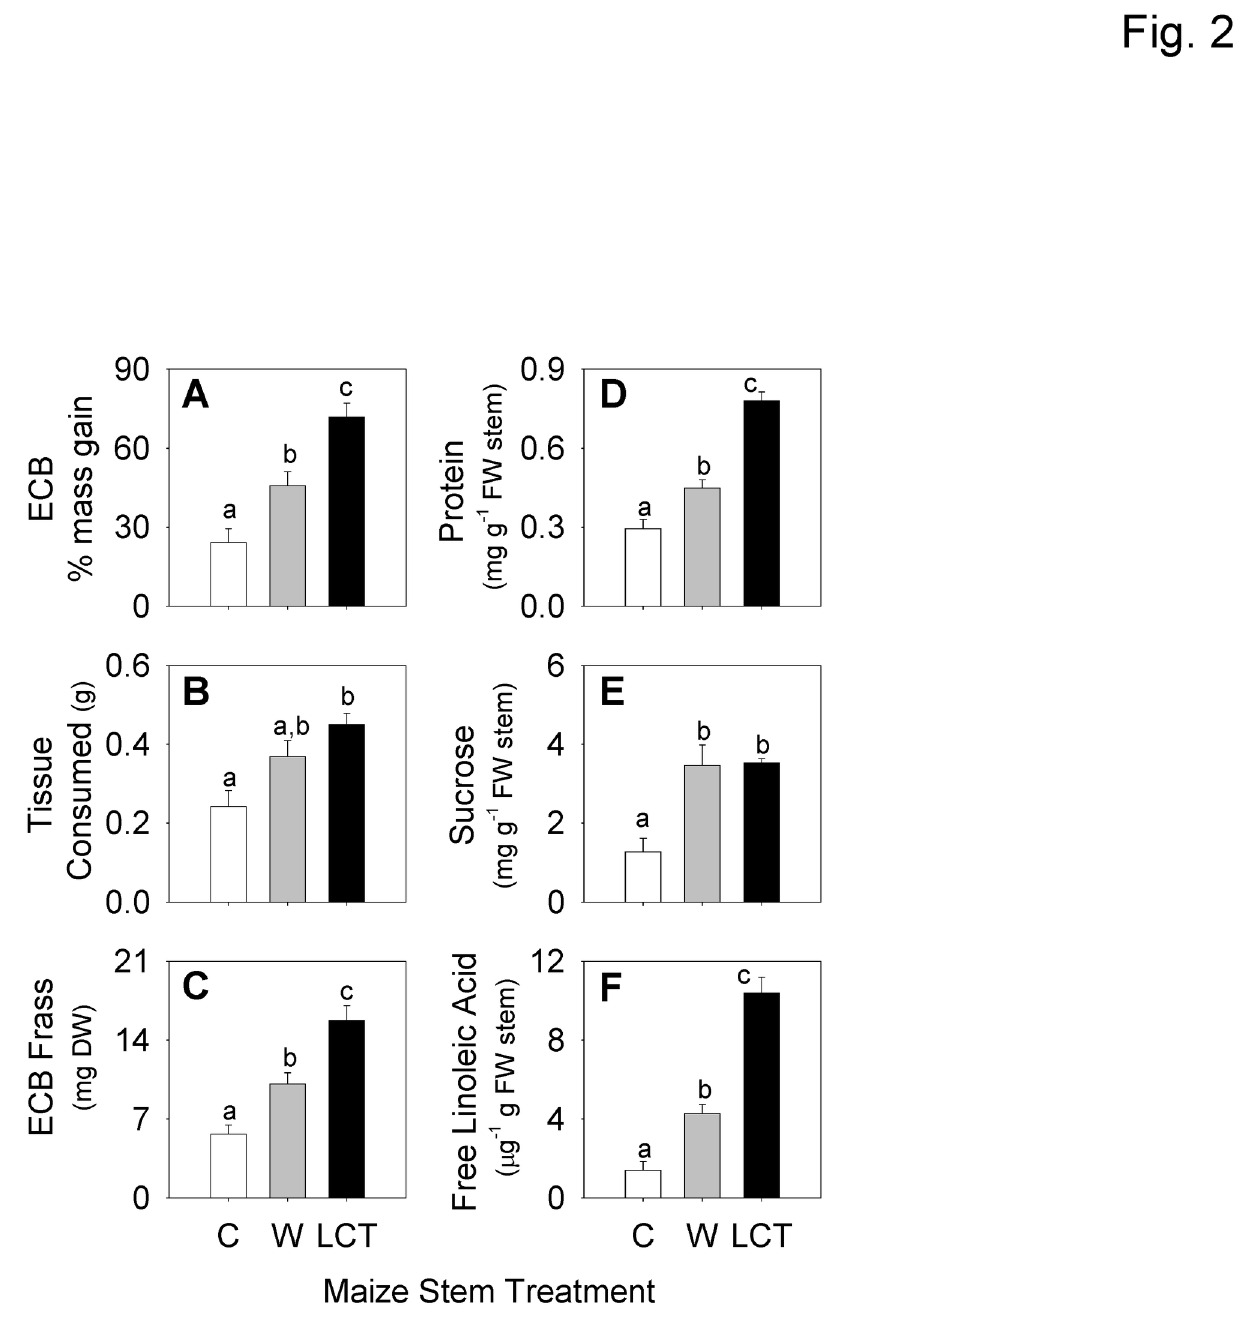
Figure 2. ECB stem herbivory improves host plant quality and subsequent larval growth. A , Average ( n = 11, +SEM) percent mass gain; B , tissue consumed and; C , frass production for ECB larvae fed for 24 h on stems that were previously treated as control (C), wound (W), or ECB larval-conditioned tissue (LCT) for 48 h. Average ( n = 6, +SEM) D , total soluble stem protein; E , sucrose and; F , free linoleic acid in comparable 48 h control, wound, and LCT stem tissues. Different letters (a–c) represent significant differences (all ANOVAs P < 0.01; Tukey test corrections for multiple comparisons, P < 0.05).